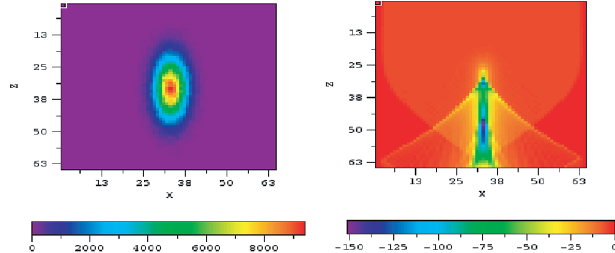
FIG. 45. PEHTS simulation result by Ohmi of horizontal and FIG. 43. (Color) Initial beam (left) and electron density (right) vertical emittance growth for the code benchmarking with the in the x (cid:2) z plane, at y (cid:3) 0 , simulated by QUICKPIC for the parameters of Table I; the horizontal scale extends over 5 ms, the CERN SPS; the electron peak density enhancement by a factor vertical from 0 to 1 : 4 (cid:7) m ; one beam-electron interaction per behind the bunch center [44]. 150 is reached 1 : 9 (cid:16) turn was considered. z